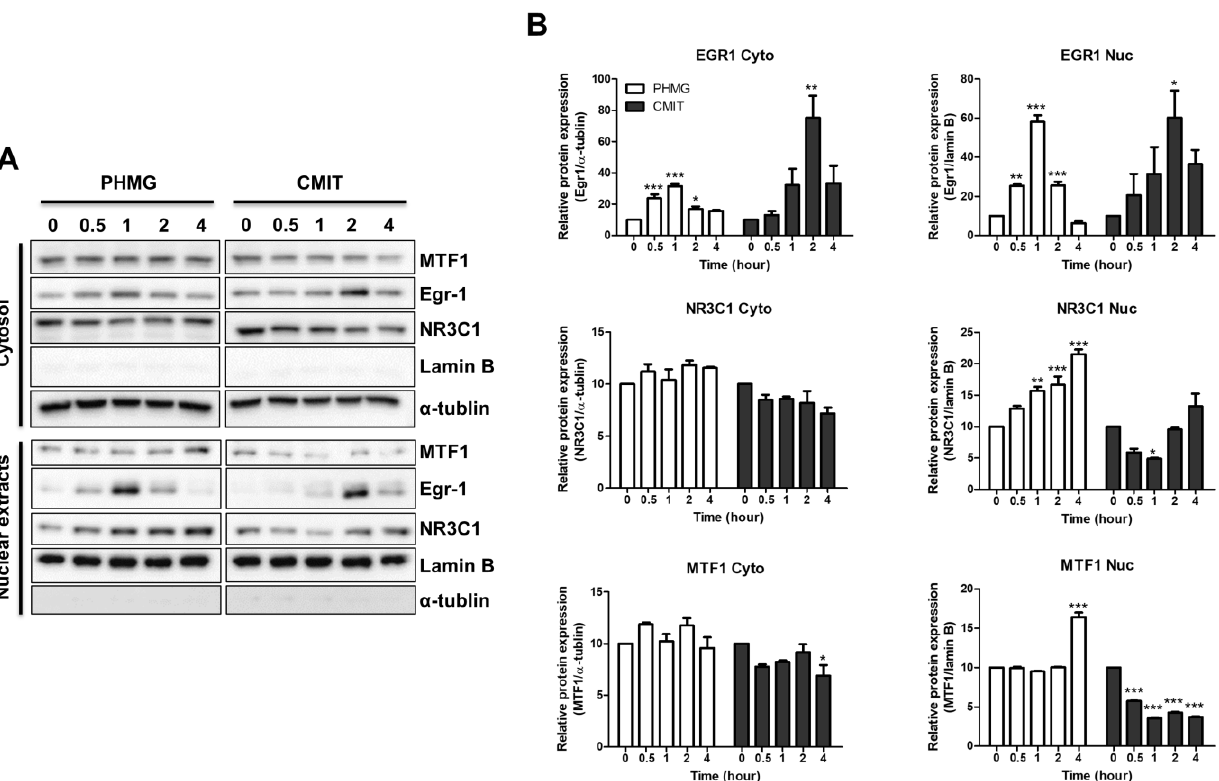
Figure 4. Effects of PHMG and CMIT on the expression levels of MTF1, EGR1, and NR3C1. HPAEpiCs were treated with 2 µ g/mL of PHMG or CMIT for the indicated time points. ( A ) Protein levels of metal regulatory transcription factor 1 (MTF1); early growth response 1 (EGR1); nuclear receptor superfamily 3, group C, member 1 (NR3C1); Lamin B; and α -tubulin were measured using Western blotting at 0, 0.5, 1, 2 and 4 h after exposure to PHMG and CMIT. Lamin B and α -tubulin were used as nuclear and cytosol loading controls, respectively. ( B ) Quantitative analysis of the protein levels of MTF1, EGR1, and NR3C1. Statistically significant differences were analyzed by one-way ANOVA (* p < 0.05, ** p < 0.01, and *** p <